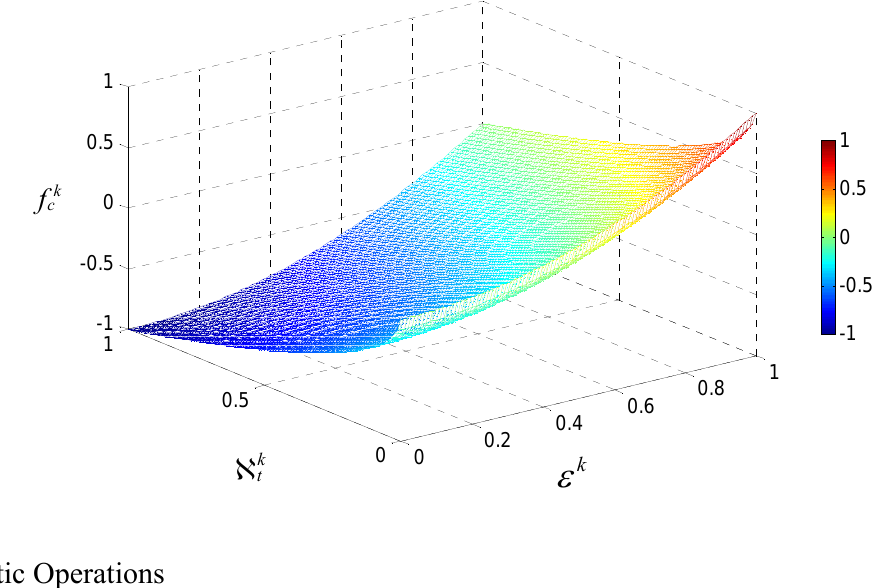
Figure 6. The response surface of c k f in 3-D space, where